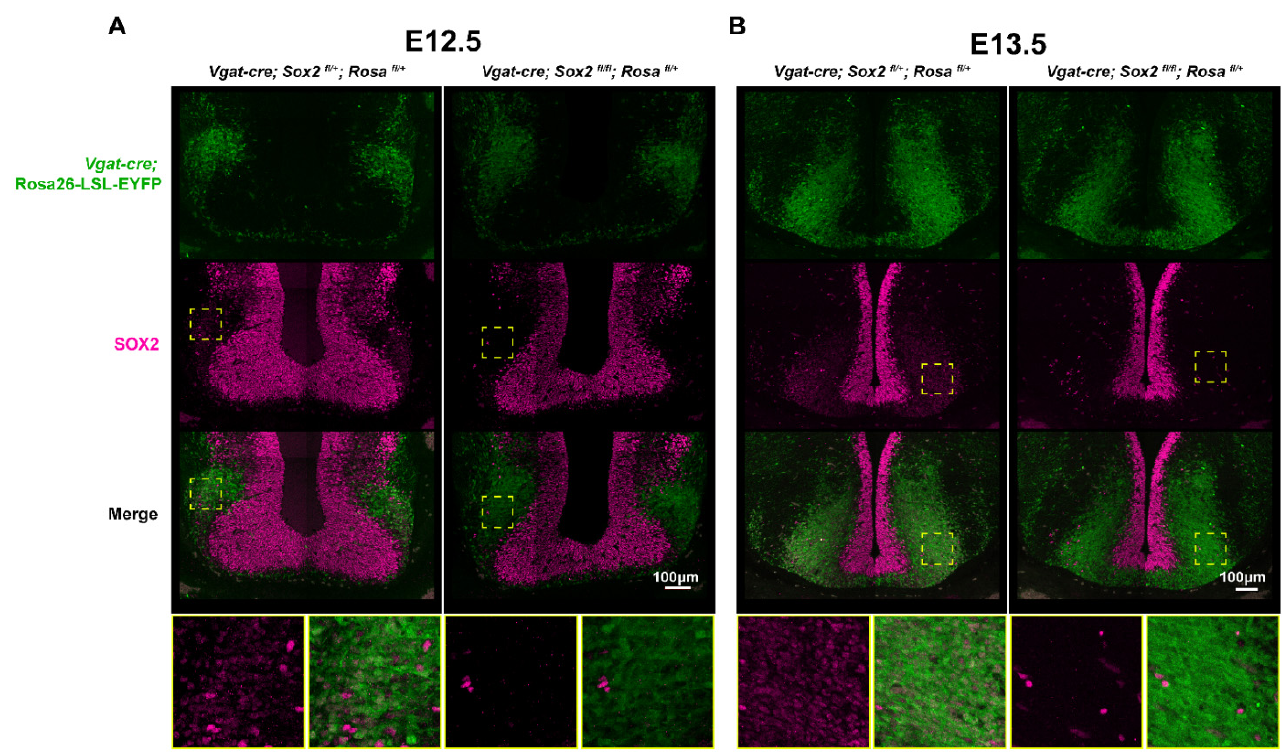
Figure 2. Cre-mediated excision of Sox2 occurs at or before E12.5 in the Vgat-cre;Sox2 fl/fl model. ( A , B ) Expression profile of EYFP (proxy for VGAT, green) and SOX2 (magenta) in the ventral anterior hypothalamus of Sox2 heterozygous ( Vgat-cre;Sox2 fl/+ ;Rosa fl/+ ) and Sox2 cKO ( Vgat-cre;Sox2 fl/fl ;Rosa fl/+ ) mice at ( A ) E12.5 and ( B ) E13.5. Yellow dotted squares highlight the parenchymal region with colocalized expression of VGAT and SOX2 in control animals, and the corresponding anatomical location in mutants. Higher magnification images of the outlined regions are shown in the bottom-most panels. One litter of E12.5 Sox2 heterozygous ( n = 2) and Sox2 cKO ( n = 2) animals were analyzed. Two litters of E13.5 Sox2 heterozygous ( n = 1 from each litter; total n = 2) and Sox2 cKO ( n = 1 from each litter, total n = 2) animals were analyzed.